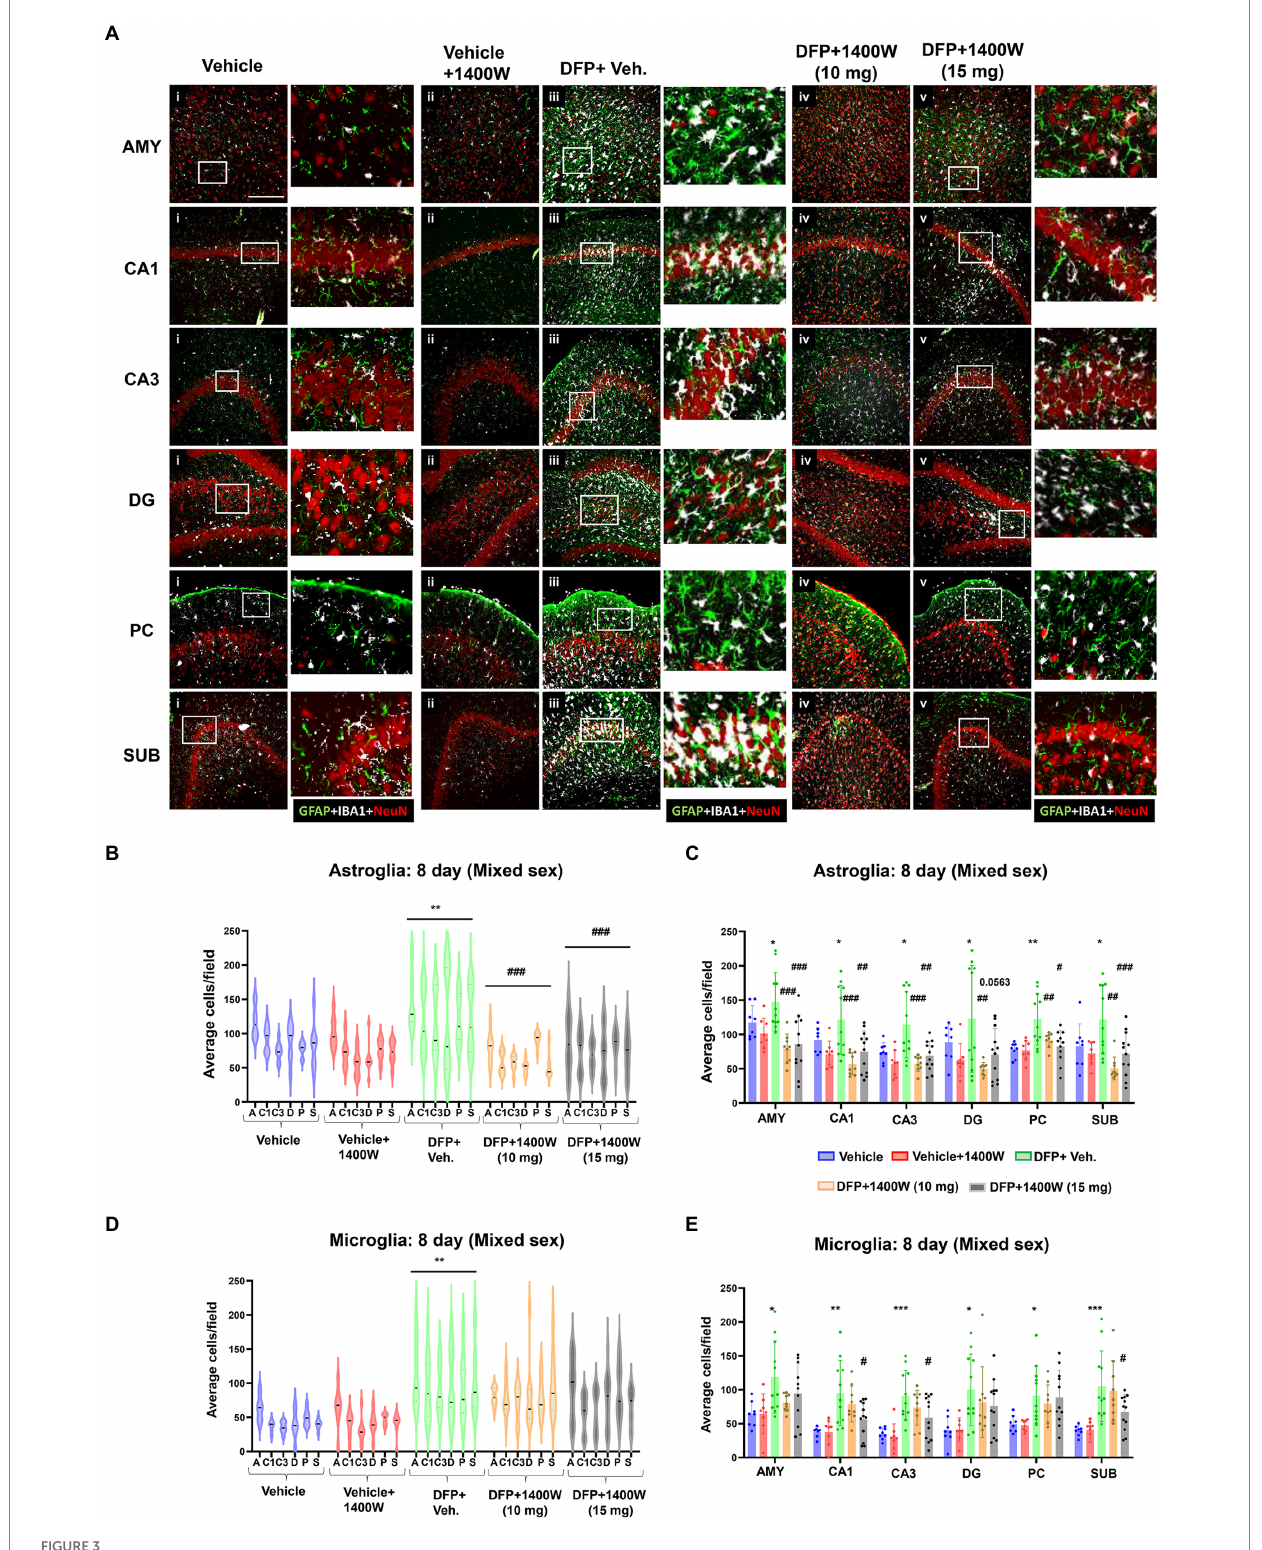
FIGURE 3 The effects of 1400W treatment for a week on DFP-induced astrogliosis and microgliosis. Representative images of GFAP (green, for astrocytes), IBA1 (gray, for microglia), and NeuN (red, for neurons) positive cells representing Amygdala (AMY), CA1, CA3, Dentate gyrus (DG), Piriform Cortex (PC), Subiculum (SUB) regions of the brains from control, vehicle+1400W, DFP + vehicle, DFP + 1400W (10 and 15 mg/kg) groups (A) . The representative enlarged images for each group and the brain regions are shown in the adjacent columns, scale bar = 50 μ M. The mixed effects model revealed a significant increase in GFAP+ve cells in brain as a whole in DFP + vehicle group and 1400W at both 10 and 15 mg/kg significantly reduced the GFAP positive cells (B) . Two-way ANOVA showed an increase in GFAP positive cells within different regions of the brain following DFP exposure and